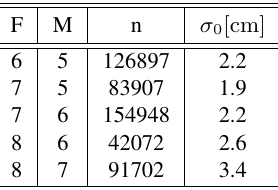
Figure 1: Histogram of the masked strip differences based on all overlapping strips. Left: original georeferencing = 8 . 4cm ). Right: improved georeferencing after strip ad- ( σ MAD = 1 . 6cm ). justment ( σ MAD